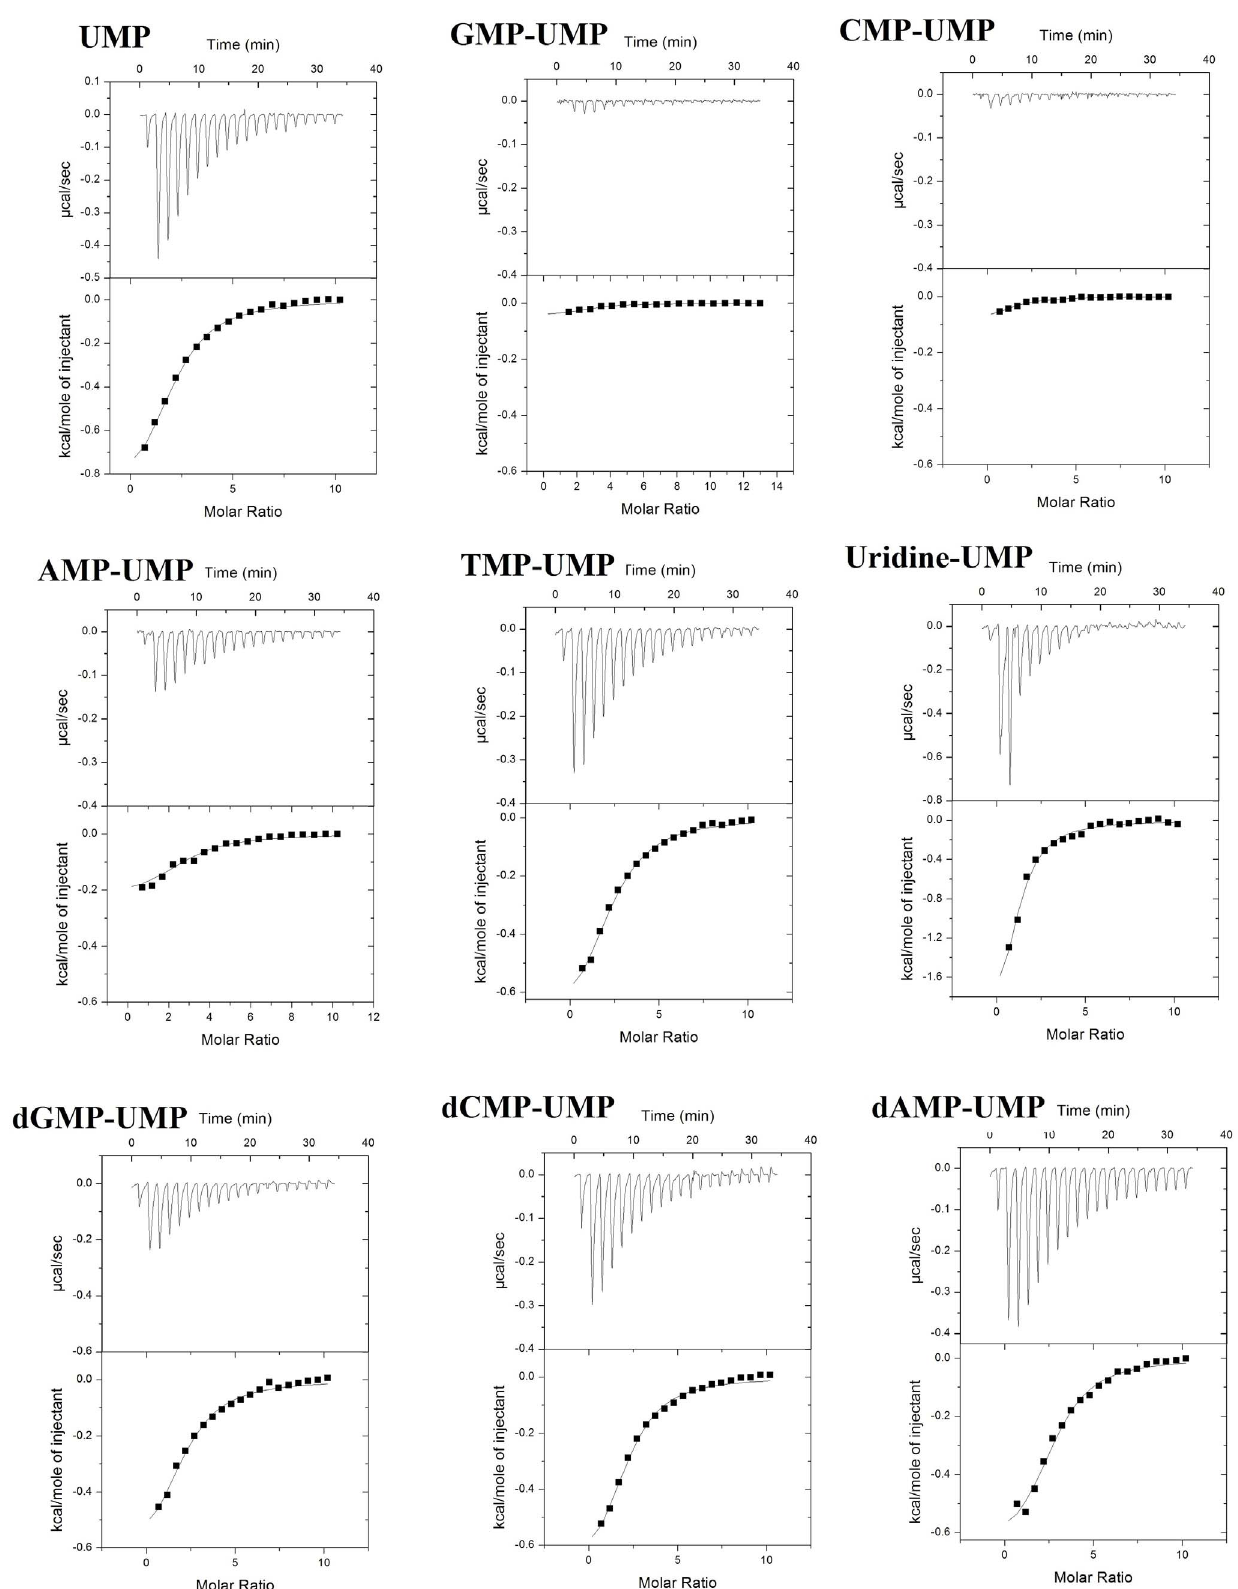
Figure 2. ITC profiles of the binding of nucleotides with the PAZ domain bound with various nucleotides.